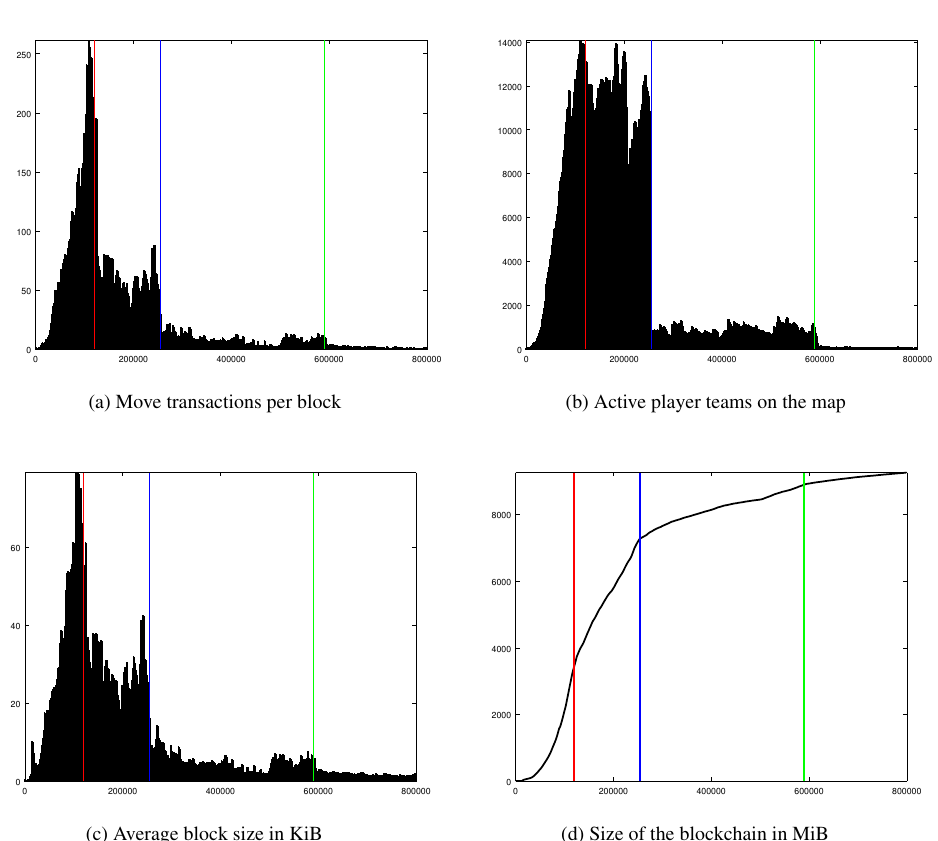
Fig. 2. Statistics about the initial 800,000 blocks of the Huntercoin blockchain. The vertical lines indicate important changes to the protocol, which prevented the network from being overloaded. See the discussion in Subsection